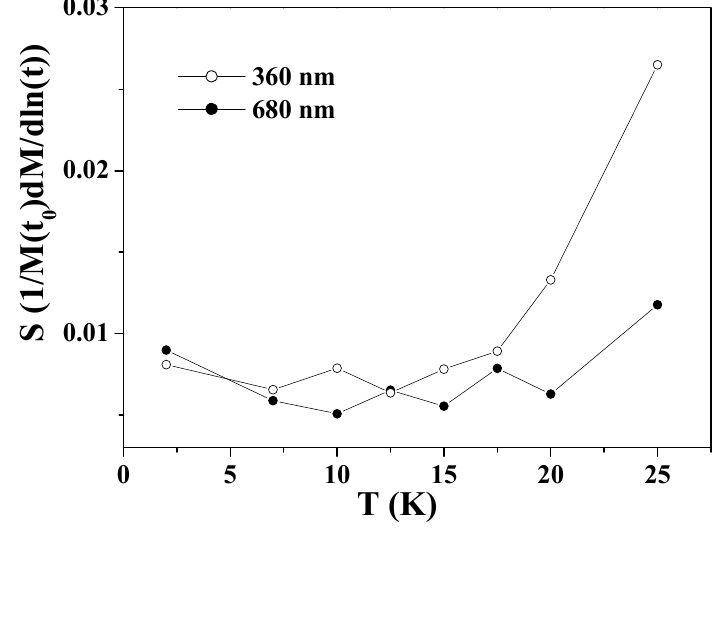
Figure 5. The magnetic viscosity S as a function of temperature for Co of 360 and 680